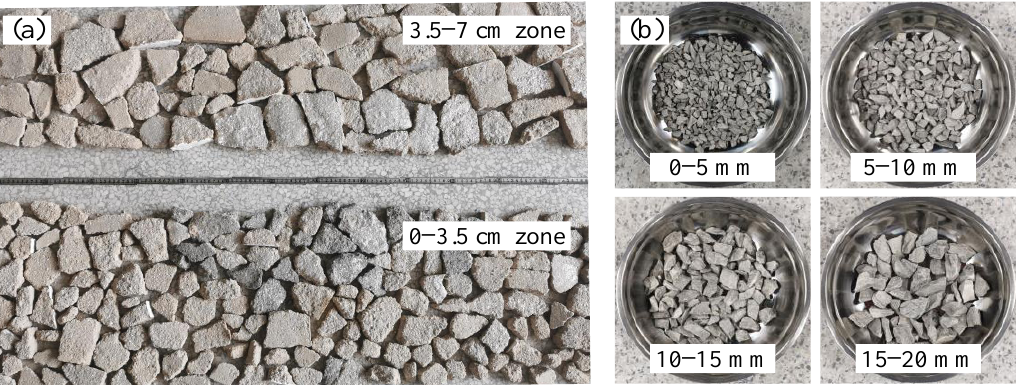
Figure 10. Similar and prototype gangue. ( a ) Similar gangue in different height zones of the caving zone. ( b ) Gangue samples with different levels of grain size grading. Table 2. Ratio of similar gangue lumpiness in different zones of the caving zone. Height (cm)